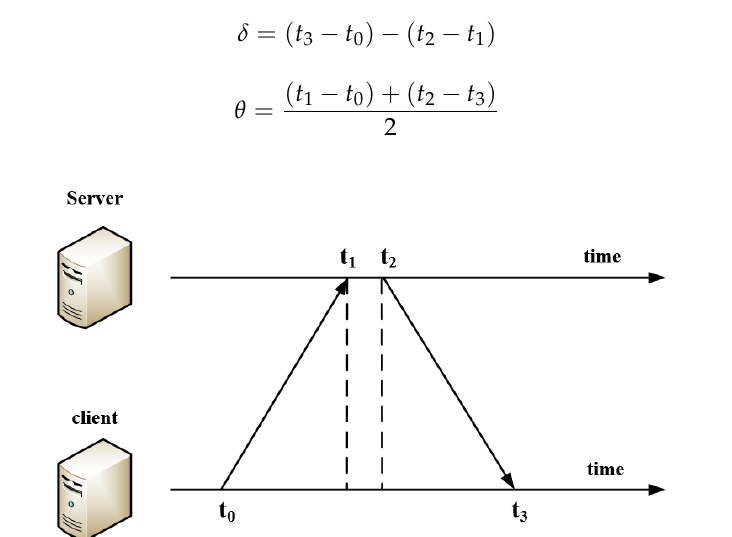
Figure 7. Network Time Protocol (NTP)